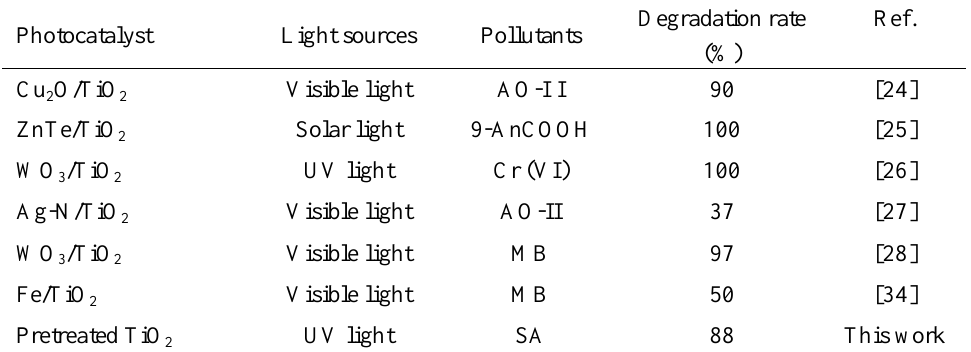
Table 1. Comparison of the Photocatalytic Activity of the Present Study with Similar